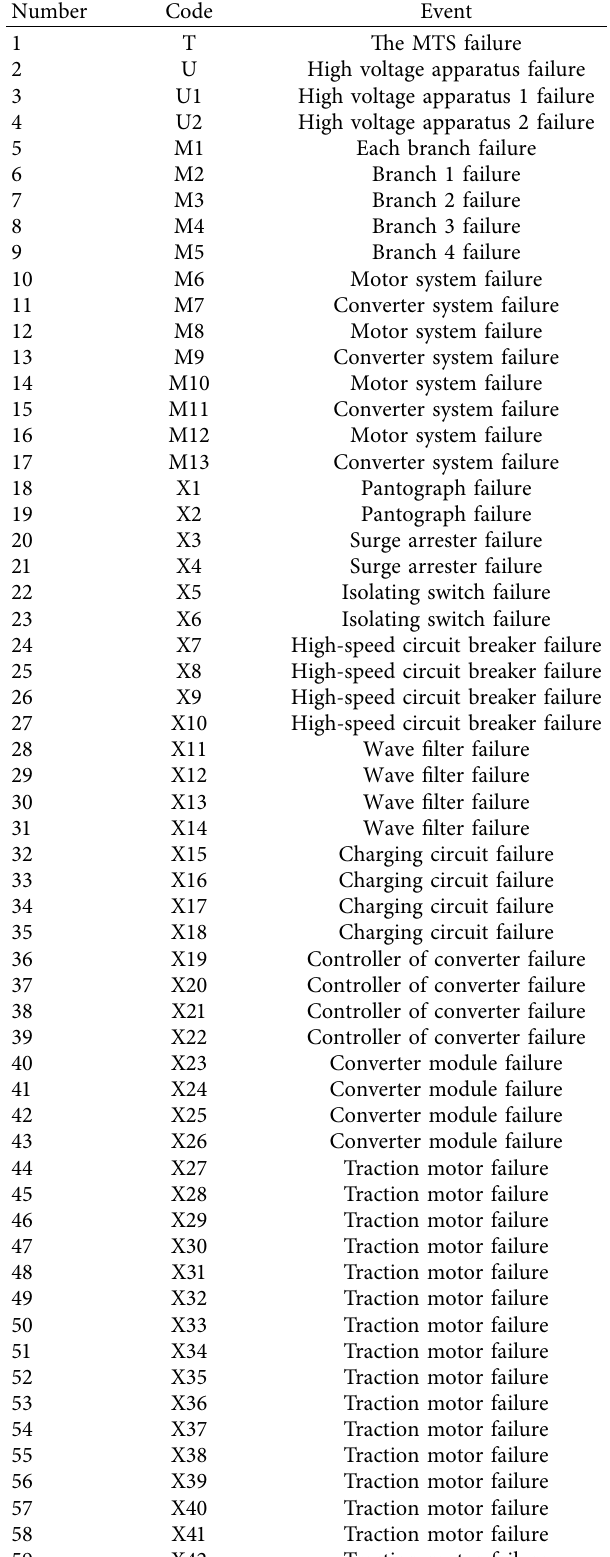
Table 14: The event represented by the corresponding code in failure